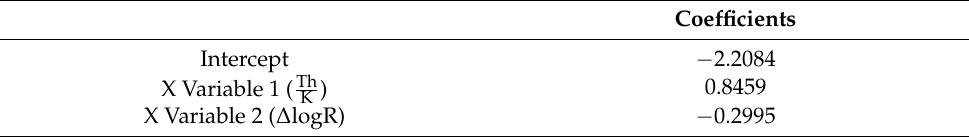
Table 8. Results of multivariate fitting of core TOC, Th/K, and ∆ log R in non-coal